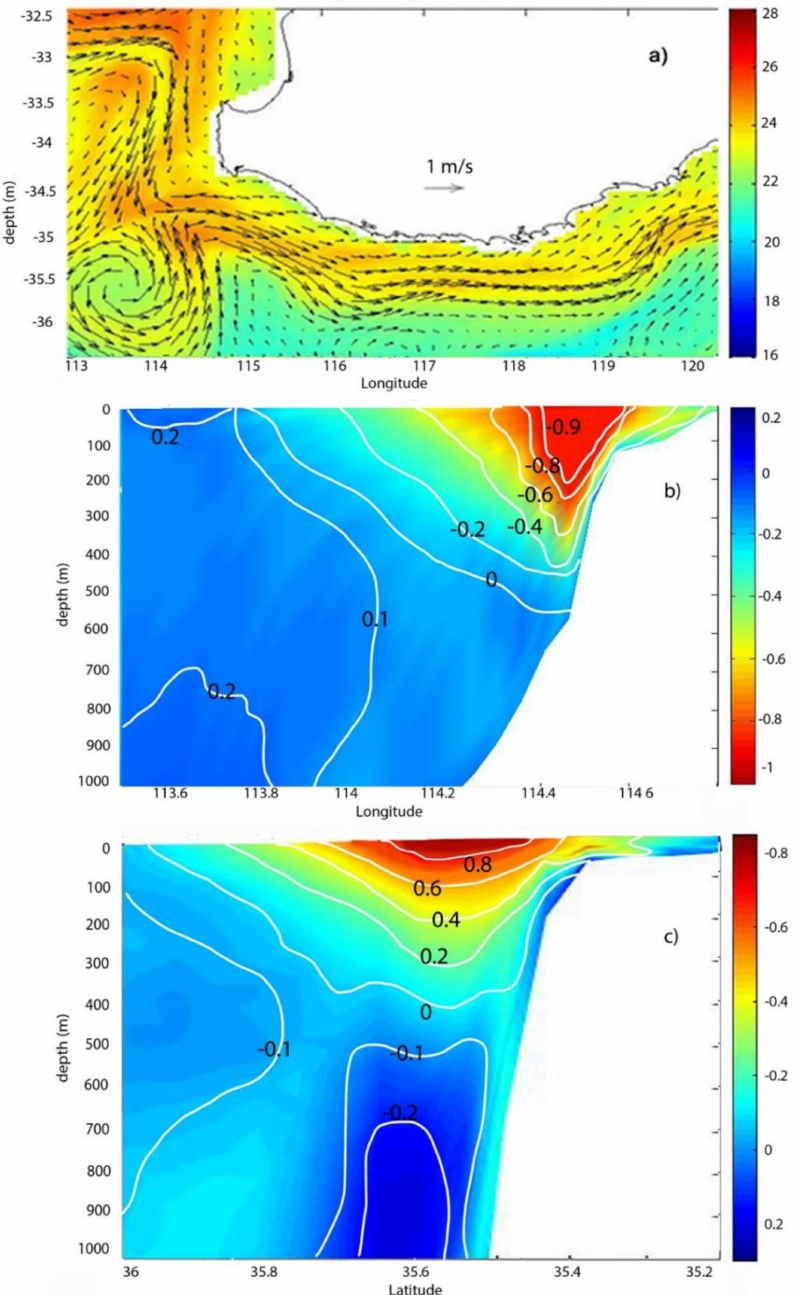
Figure 6. Model output with wind stress forcing representing winter conditions. ( a ) Sea surface temperature ( ◦ C) and current velocities; ( b ) the cross-section across transect R (Capes region) showing the north-south velocity (m / s); ( c ) the cross-section across transect K (Albany) showing the east-west velocity (ms − 1